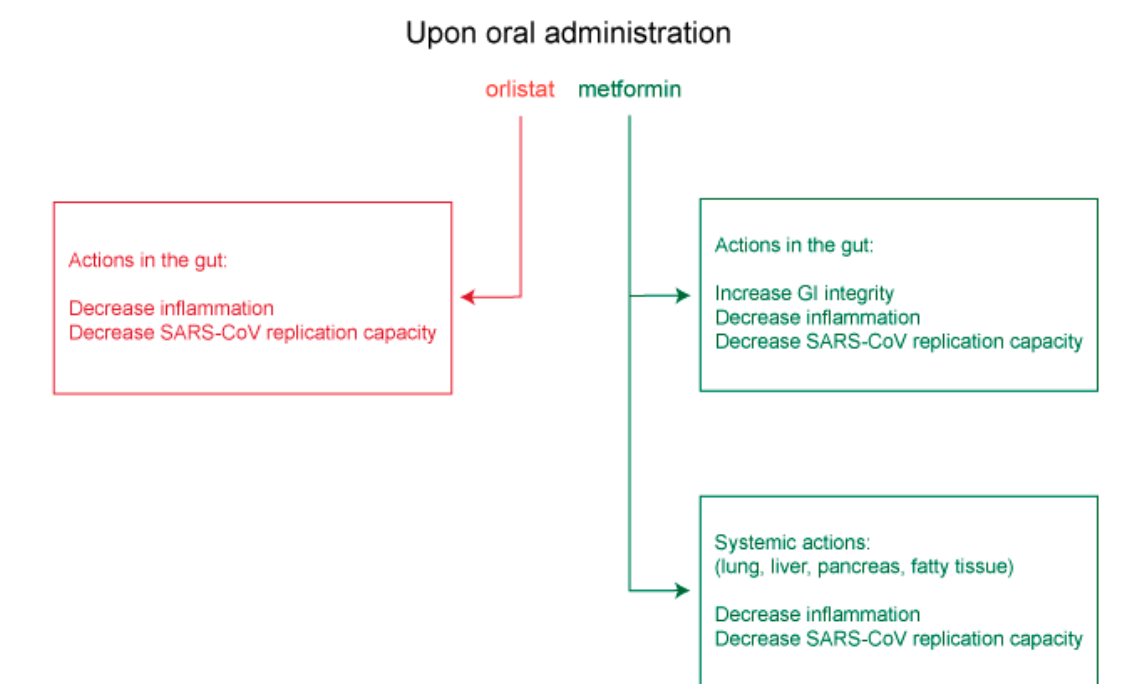
Figure 5. Predicted systemic actions by orlistat and metformin in inhibiting COVID-19 disease and pathologies. If used in conjunction with other antivirals and anti-inflammatory drugs, orlistat and/or metformin may further suppress SARS-CoV-2 replication through overall lowering of lipid synthesis for a reduction in replication organelles and prevention of viral